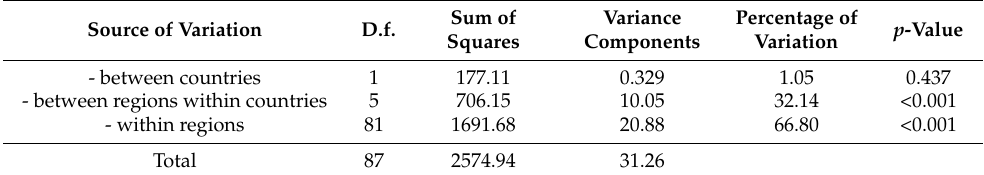
Table 4. Analysis of molecular variance (AMOVA) partitioning different geographical levels (regions and countries) estimated from R ST parameters based on the VNTR-rep